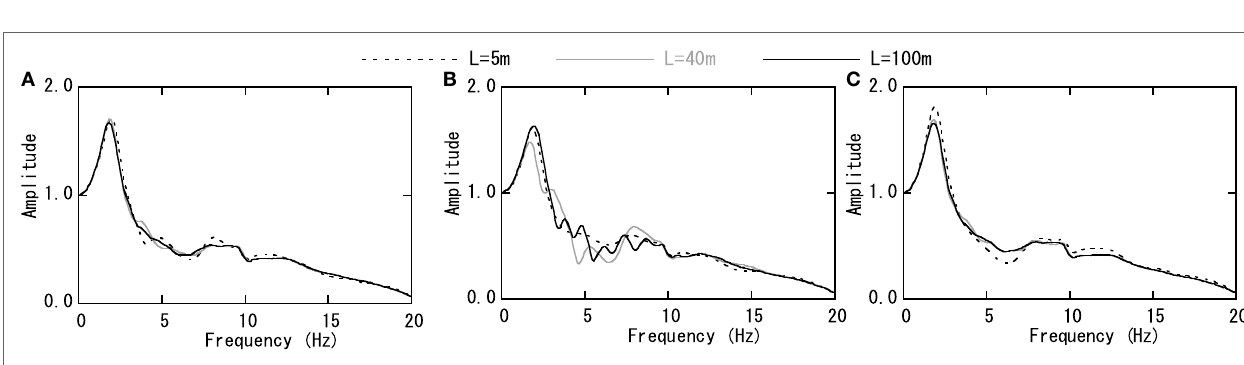
FigUre 11 | comparison of input motion (horizontal excitation) . (a) TB. (B) VB without EF. (c) VB with EF.